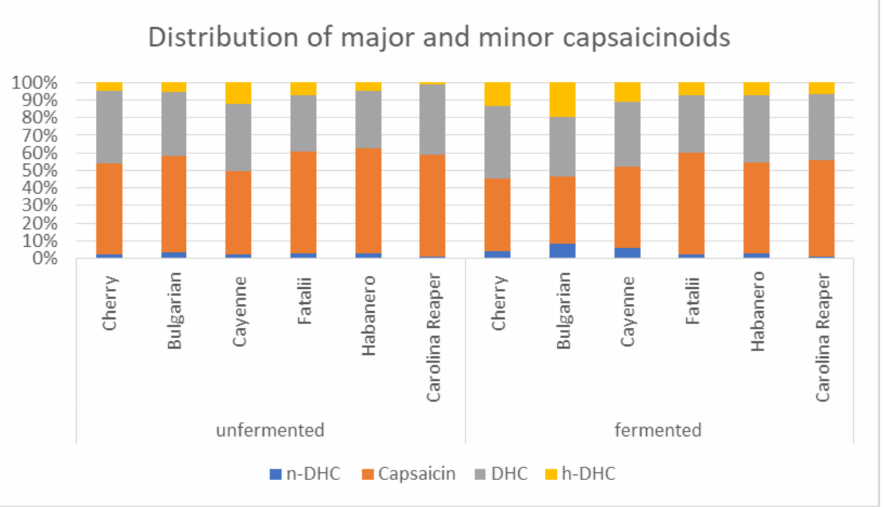
Figure 1. Mean distribution (%) of major and minor capsaicinoids in the fresh and fermented chili samples. In order to evaluate the pungency of the samples, expressed in Scoville Heat Units (SHU) based on the Scoville scale, results of capsaicinoids content (parts per million— ppm) were multiplied with standard coefficient values, specific for the pungency of the individual capsaicinoids, results being correlated to dry weight, as described by Dueland.